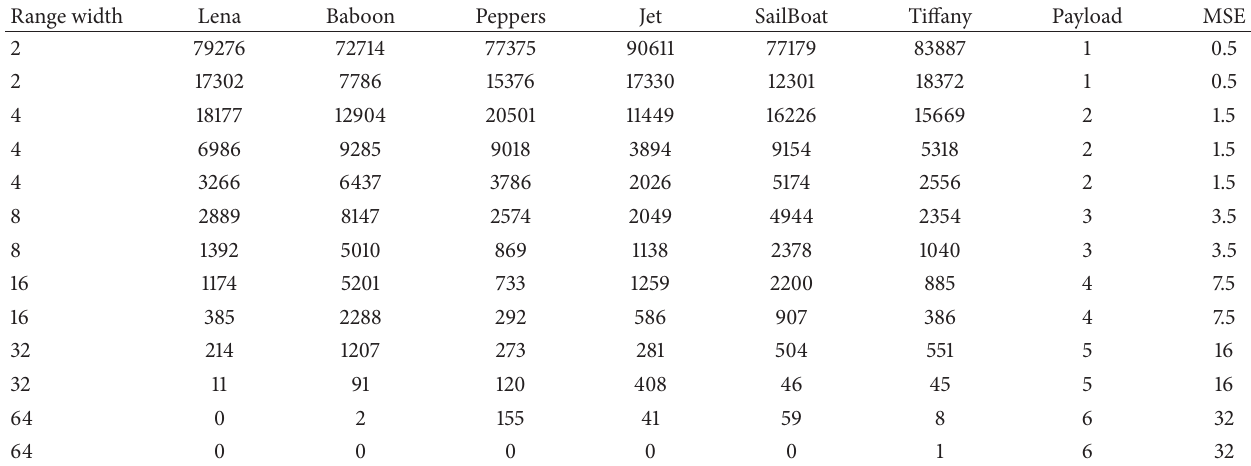
Table 3: The distributions of pixel-value difference, payload, and MSE for images using Wu and Tsai’s method. Range width